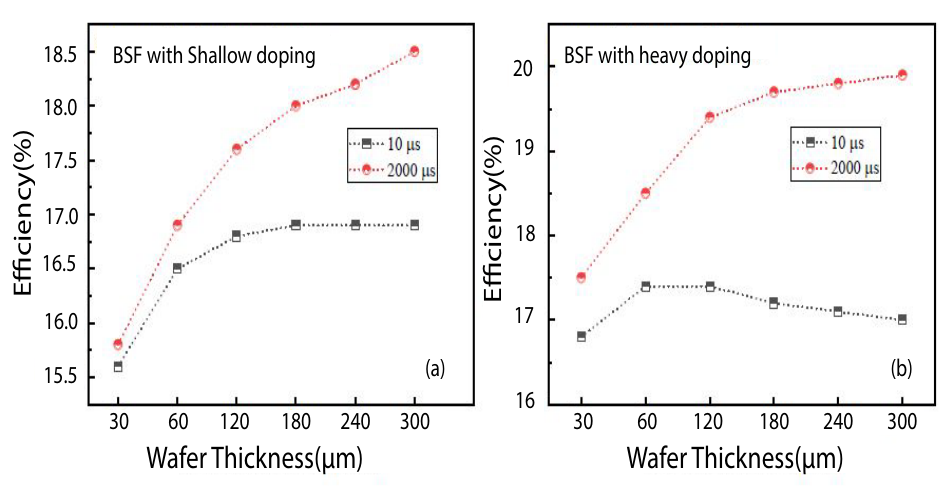
Figure 8. Efficiency variation with respect to bulk lifetime ( a ) BSF with shallow doping, ( b ) BSF with heavy